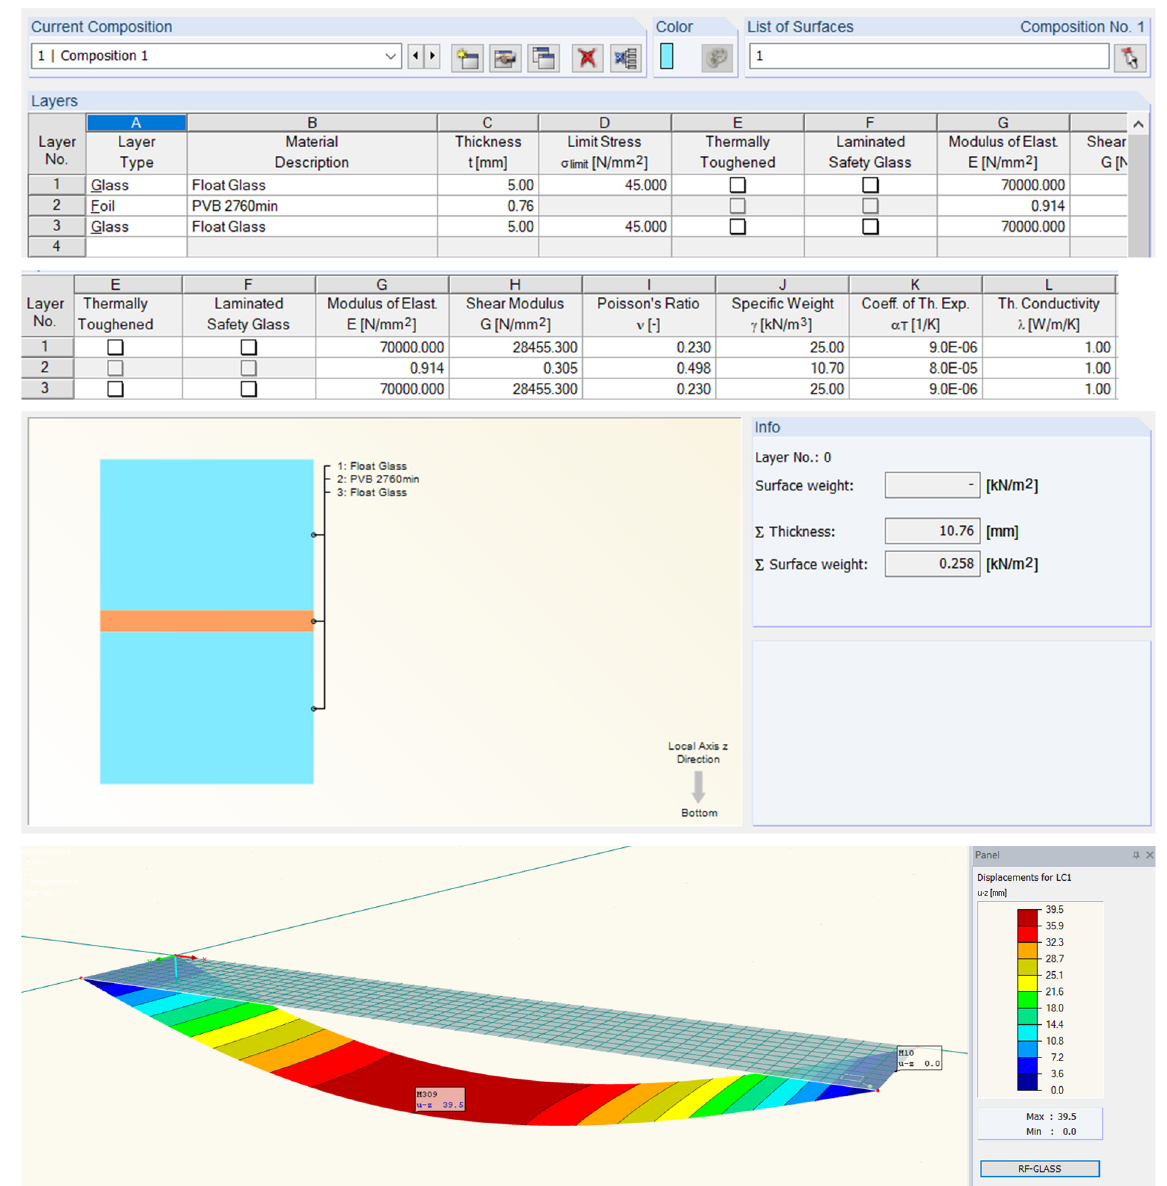
Figure 15. Dlubal RFEM—RF GLASS for glass design. Thermo-rheological temperature dependence for time domain viscoelasticity was defined from the suboptions menu (TRS) inside of the material definition for the PVB interlayer. Shift function approximation was defined as Williams–Landel–Ferry (WLF). Reference temperature theta Θ was chosen at 50 ◦ C as suggested by [14] and the WLF factors C 1 s = 8.86 and C 2 s = 101.6. Young modulus and Poisson’s ratio for the elastic properties of foil were selected for the exact time and temperature (1500 min and 39.4 ◦ C). Interpolated elastic relaxation modulus was obtained from the Trosifol ® table E = 0.591 MPa and Poisson’s ratio 0.495. The results are shown in Figure 18. Results fit the measurement data with almost 100%